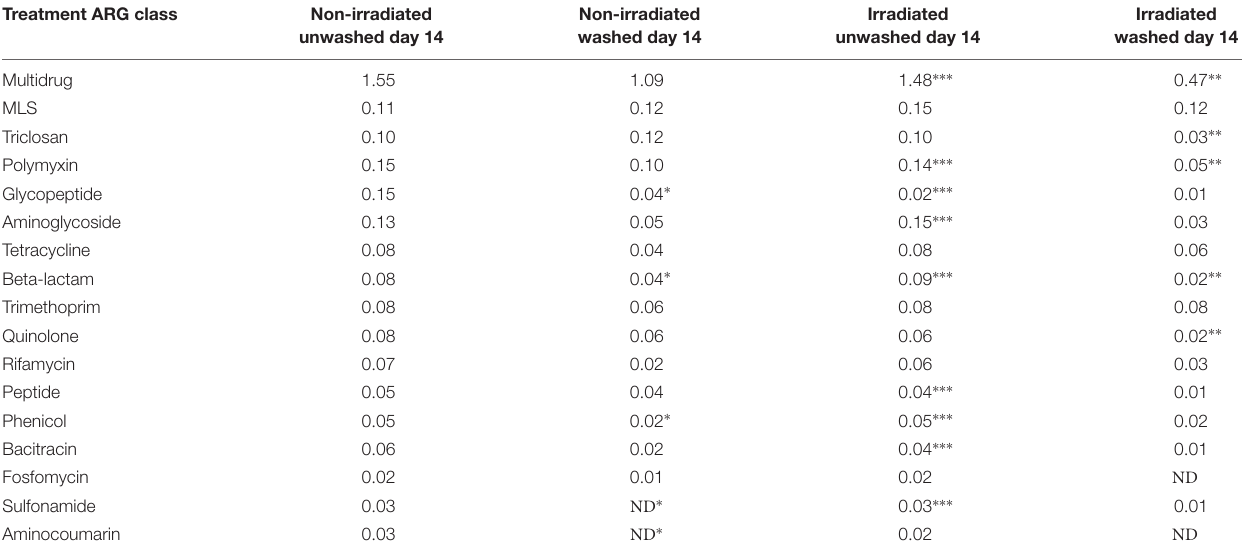
∗ indicates statistical difference (p < 0.05, Wilcoxon) between unwashed and washed non-irradiated samples. ∗∗ indicates statistical difference (p < 0.05, Wilcoxon) between non-irradiated and irradiated washed samples. ∗∗∗ indicates statistical difference (p < 0.05, Wilcoxon) between unwashed and washed irradiated samples. MLS, Macrolide-lincosamide-streptogramin. ND indicates not detected.